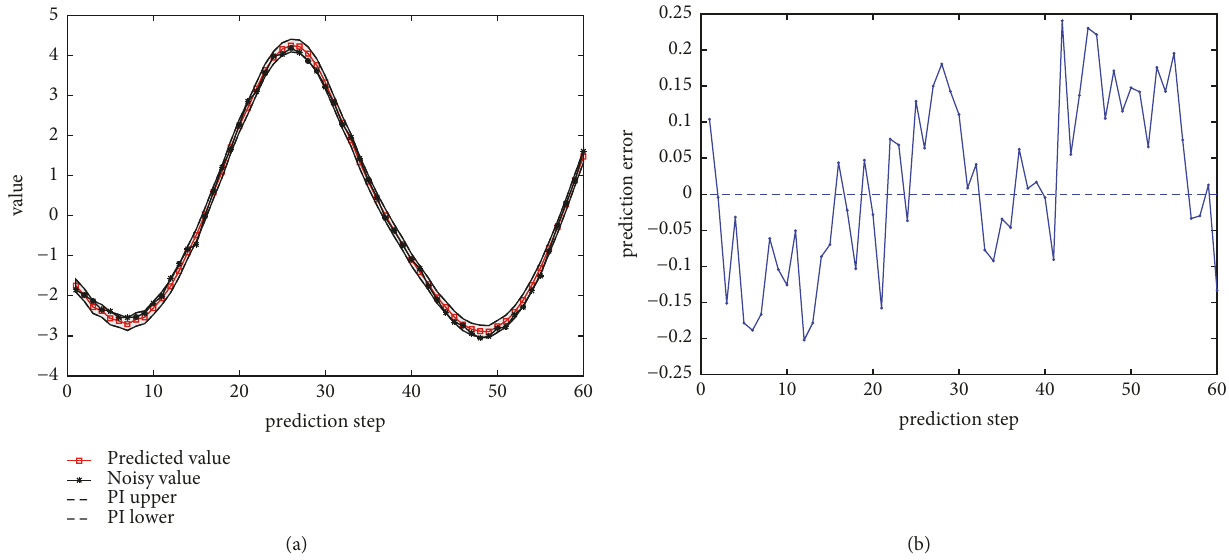
Figure 6: Prediction results for the noisy MSO problem: (a) the constructed PIs; (b) the corresponding predicted